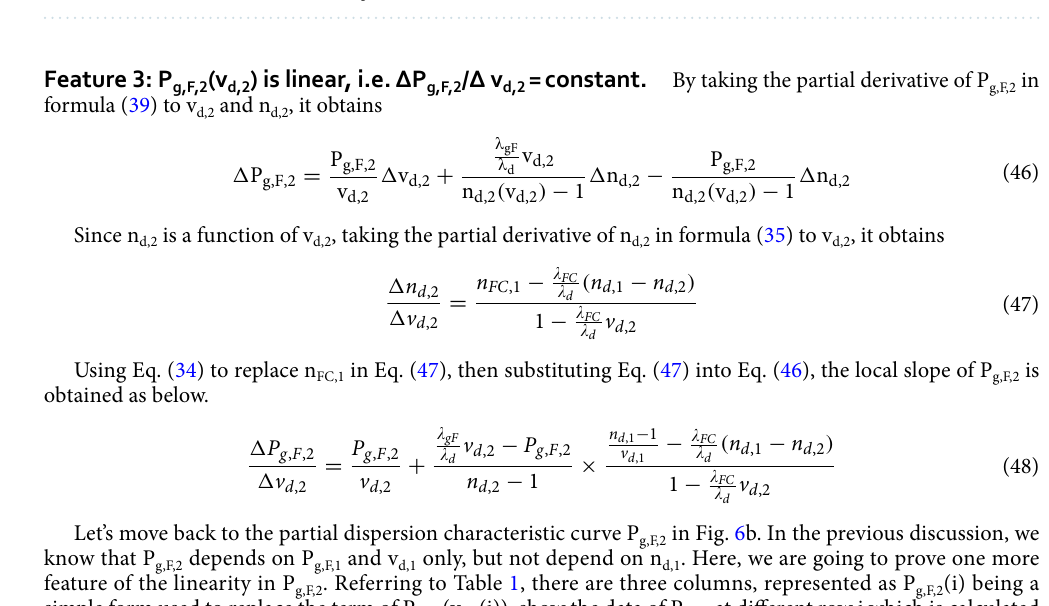
Table 1. Equivalent results of the local slopes, i.e. ΔP g,F,2 (i)/Δv d,2 (i) = S(i) = constant, calculated by formula (39) and Eq. (48) show the linearity of P